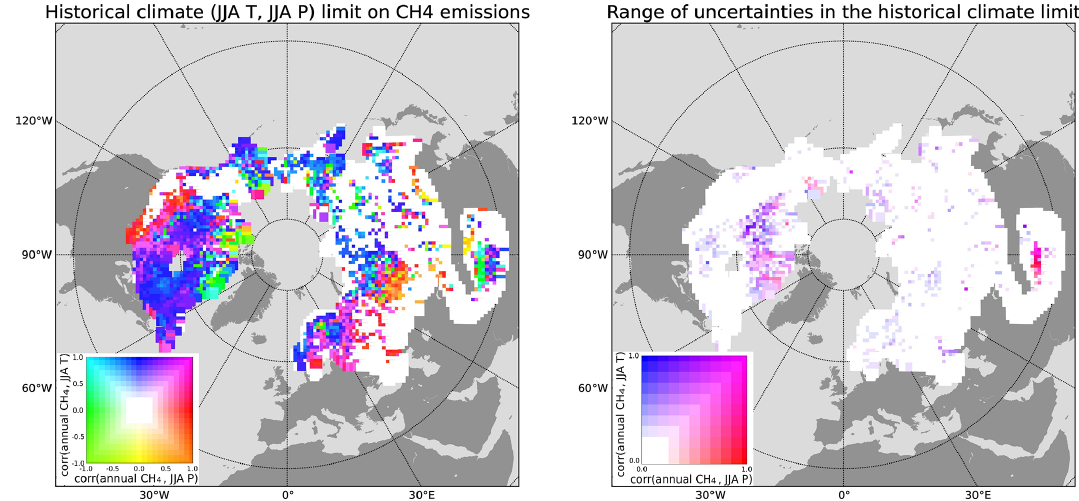
Figure 7. Spatial distributions of ensemble median (left) and range at 95% confidence level (right) of correlations between annual CH 4 emissions and JJA T and P . The green-red and yellow-blue axes depict the strength of correlation ( − 1 to 1) with JJA P and JJA T , respectively.